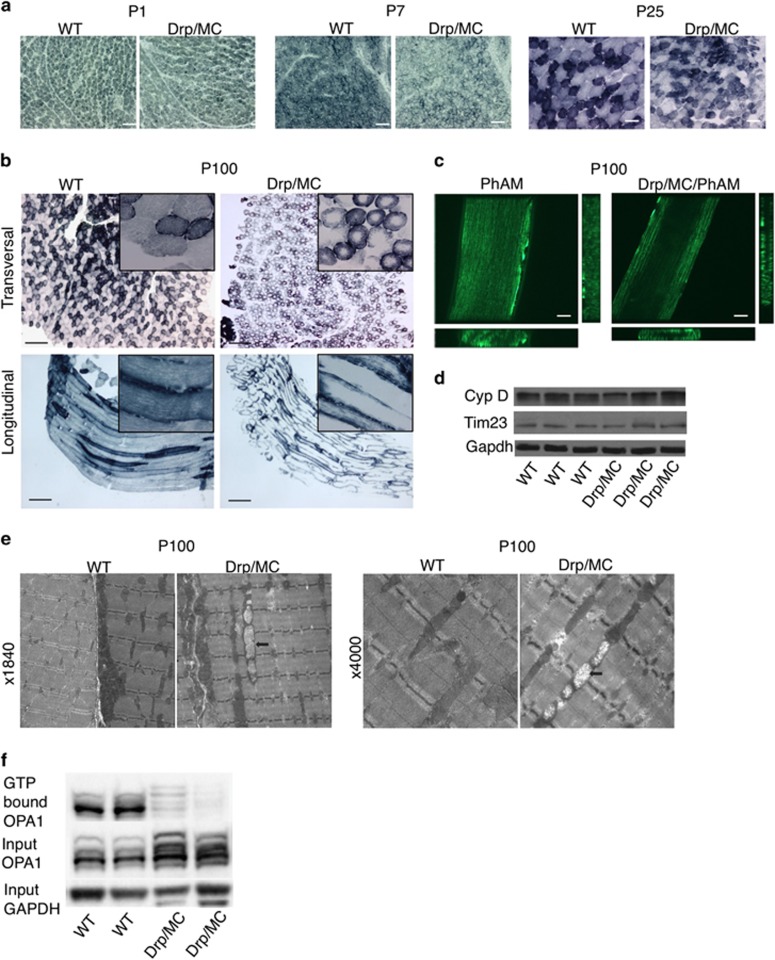
Muscle-specific Drp1 overexpression induces a drastic remodelling of mitochondrial network. (a) SDH staining of transversal sections from WT and Drp/MC from P1, P7, P25 TA muscles. Original magnification × 20, scale bar: 50 μm. (b) SDH staining of transversal and longitudinal sections from WT and Drp/MC P100 TA muscle. Low magnification, × 4; high magnification, × 40. (c) Representative confocal images of mitochondrial network in PhAM and Drp/MC/PhAM TA myofibres from P100 animals. Transversal and longitudinal optical sections are also shown. Original magnification x40, scale bar: 10 μm. (d) Western blot analysis of Tim23 and Cyclophilin D (CypD) protein expression levels in mitochondrial protein lysates from quadriceps of adult WT and Drp/MC mice. Gapdh was used as internal control. (e) Electron microscopy analysis of TA muscles from P100 Drp/MC and WT mice. Arrows point to swollen mithocondria, with none or fewer than normal cristae. (f) Western blot analysis of Opa1 GTPase activity after pull-down experiments using GTP-conjugated beads